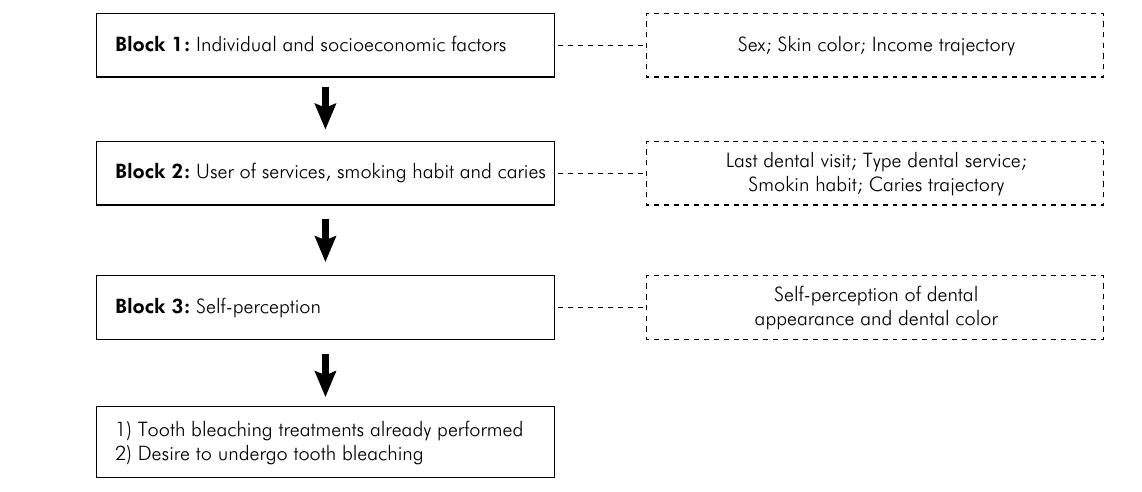
Figure. Theoretical model for analysis of desiring and having performed dental bleaching and independent variables.